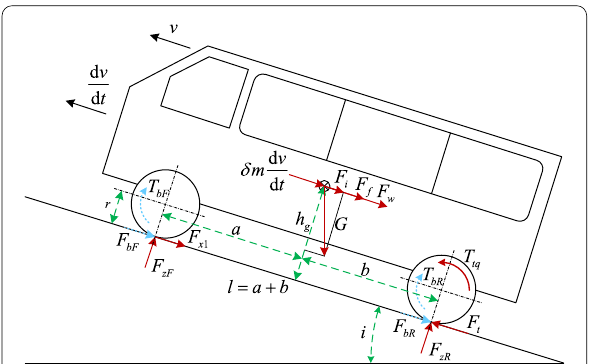
Figure 3 Longitudinal dynamics model on a